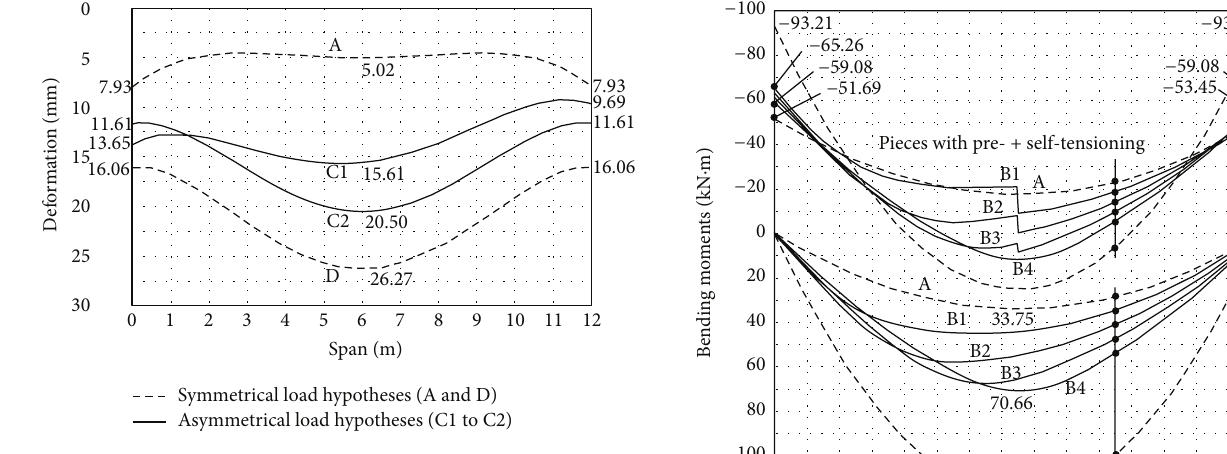
Figure 11: Deformation hypotheses (A), (C1), (C2), and (D), F1 structural floor, section (S2).